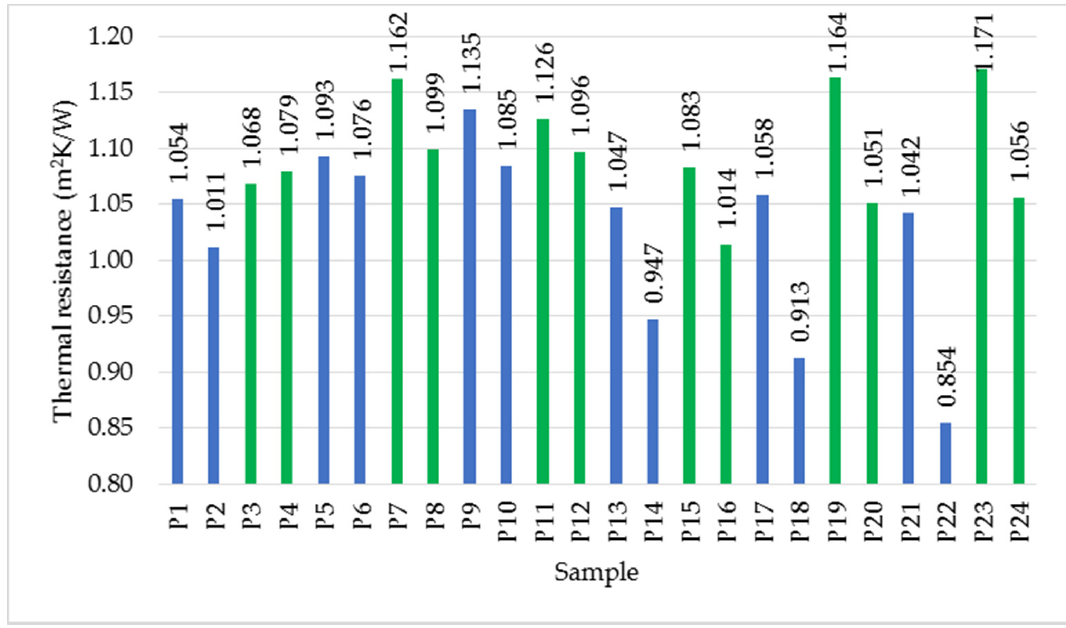
Figure 11. Variation of thermal resistance, average values. Notation: blue—samples made with resin, green—samples made with latex.